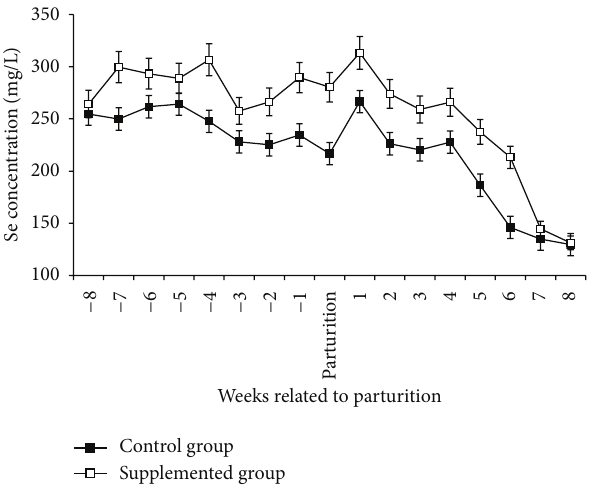
Figure 1: Plasma Se concentrations (mean ± SEM) of Se supple- mented and control ewes.